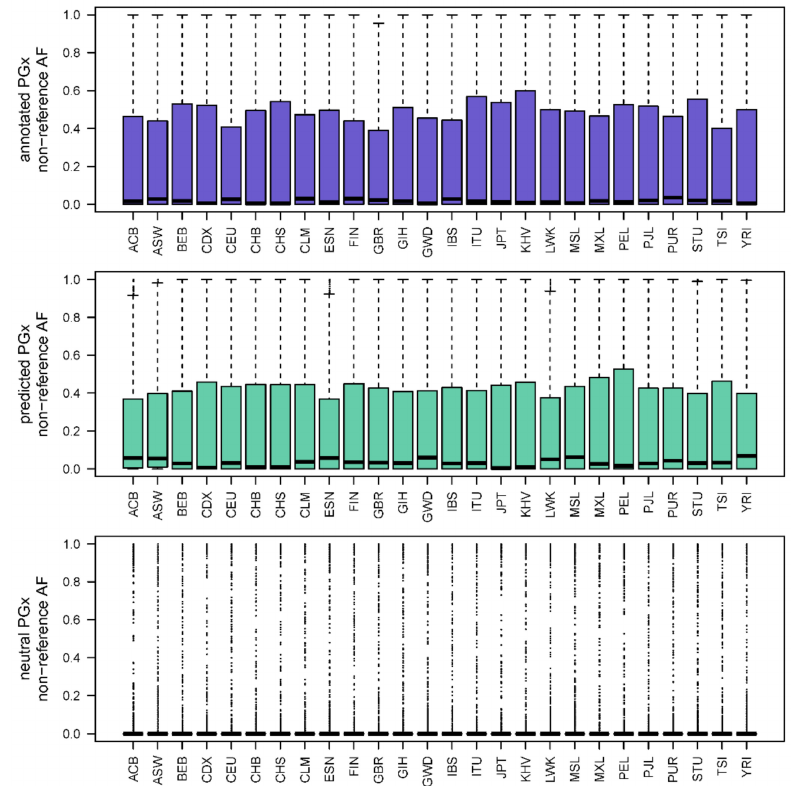
Figure 3. Allele frequency distributions across functional variant categories and population